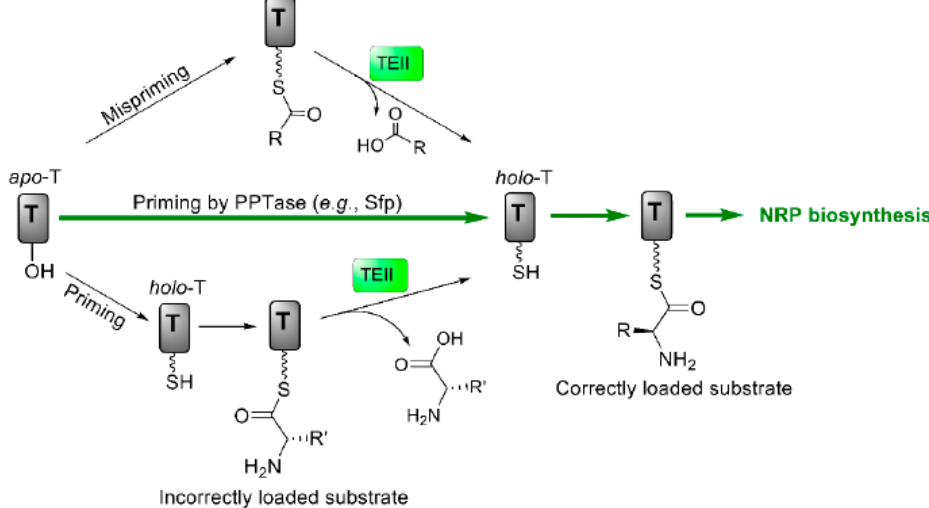
Figure 5. Regeneration of the functionality of T domains catalyzed by type II thioesterase (TEII). T, thiolation domain; PPTase, phosphopantetheinyl transferase; NRP, nonribosomal